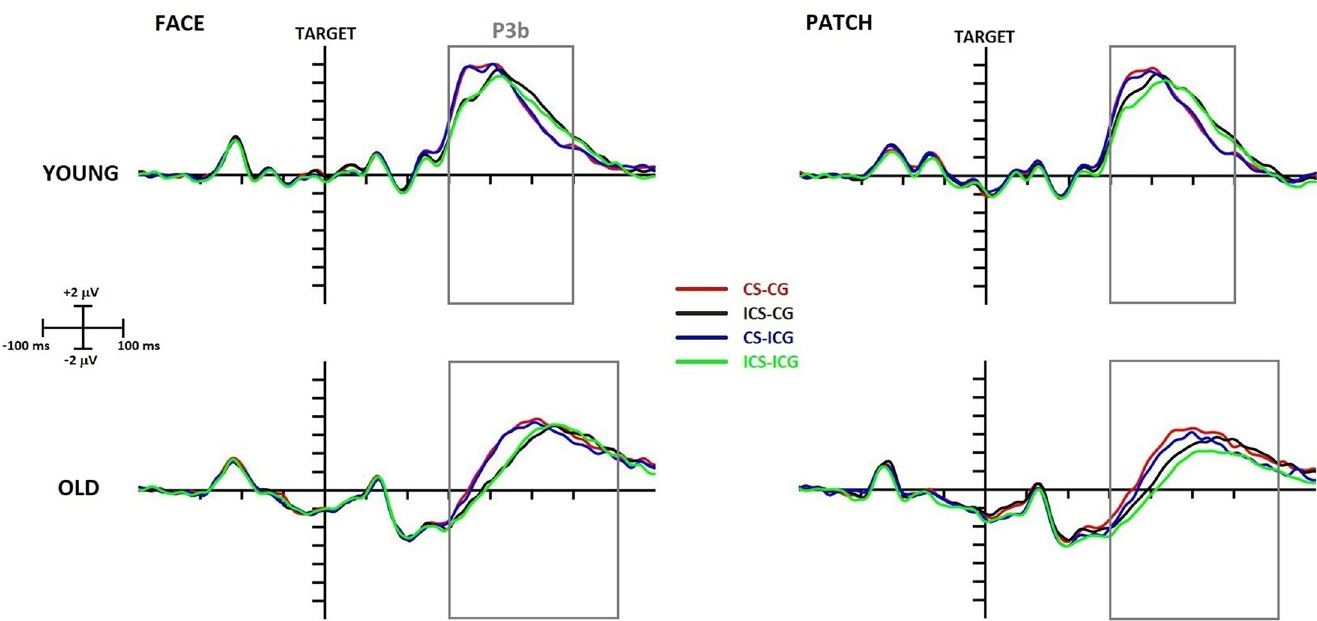
Fig 6. Target-locked P3b component at the Pz electrode site in young (top row) and older (bottom row) adults and in face (left side) and patch (right side) trials. The x-axis represents the epoch from -450 ms to 800 ms around the time-point of target presentation. CS-CG (congruent Simon, congruent gaze) waveforms are displayed in red, ICS (incongruent Simon)-CG waveforms in black, CS-ICG (incongruent gaze) waveforms in blue, and ICS-ICG waveforms in green. Grey rectangles represent the search window for maximal P3